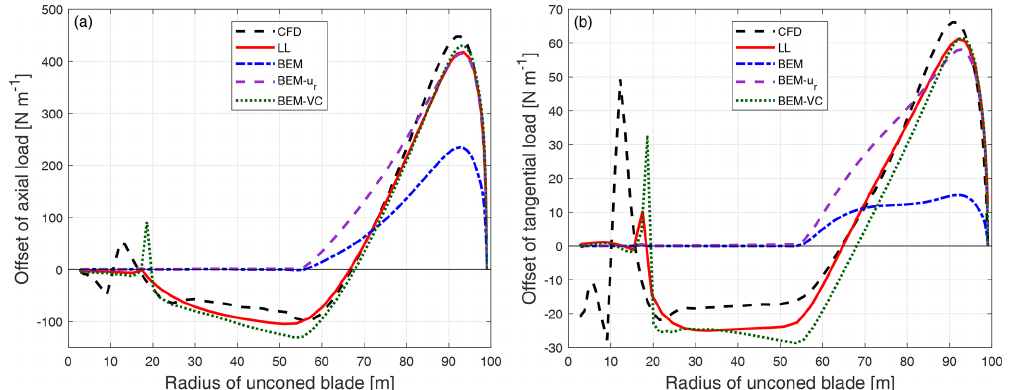
Figure 16. Comparison of the difference of the axial load (a) and tangential load (b) of the upwind dihedral blade W-1 with 15 ◦ of cone downwind compared to the baseline blade with the same cone calculated from CFD, the lifting-line method (LL), the BEM method, BEM with radial induction (BEM- u r ) and the proposed BEM-VC method.